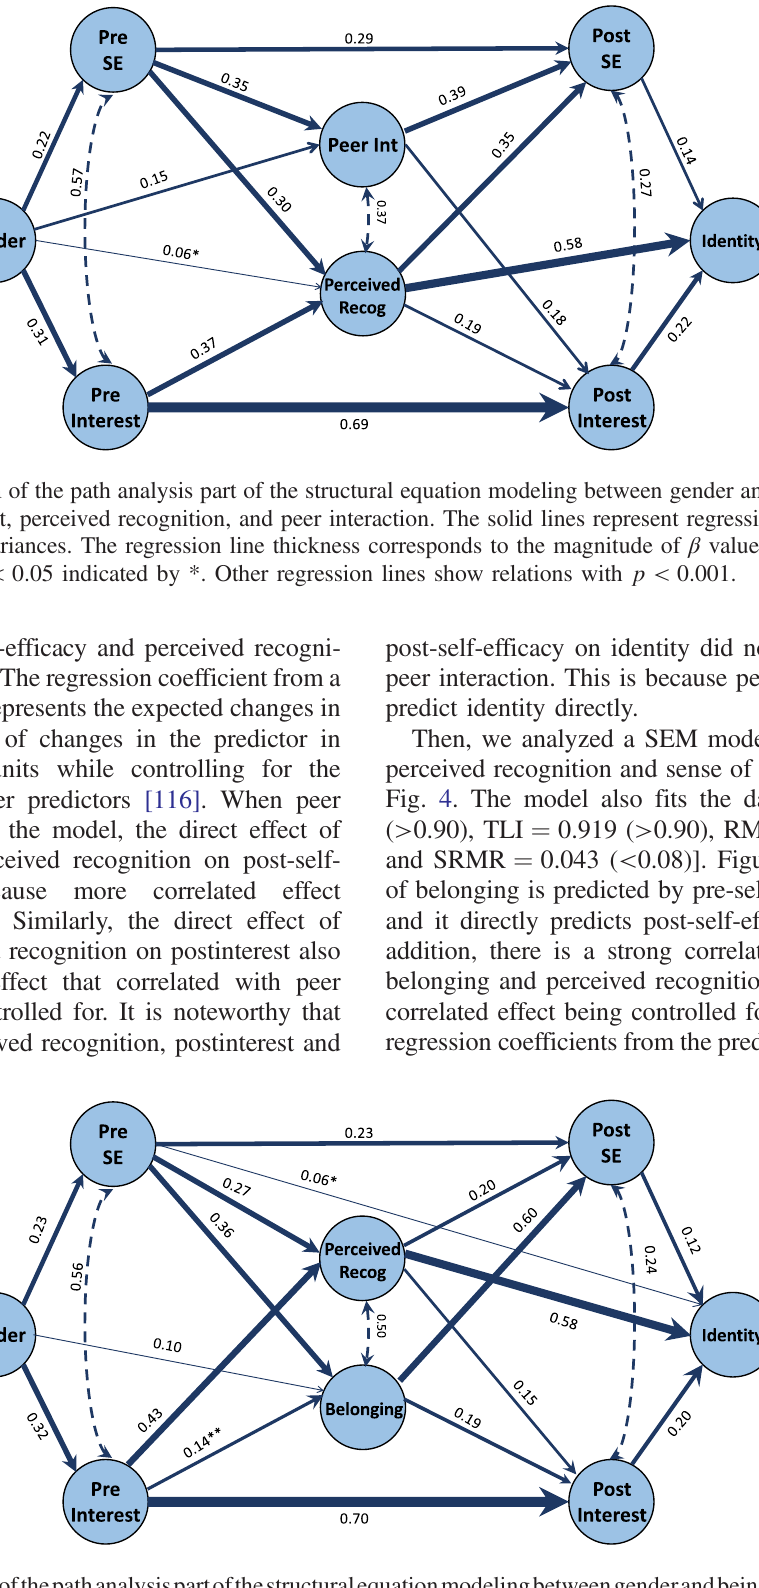
FIG. 4. Schematicdiagramofthepathanalysispartofthestructuralequationmodelingbetweengenderandbeingaphysicspersonthrough self-efficacy, interest, perceivedrecognition, and peer interaction. The solid lines represent regression paths, and the dashed lines represent residual covariances. The regression line thickness corresponds to the magnitude of the β value (standardized regression coefficient) with 0 . 01 < p < 0 . 05 indicated by * and 0 . 001 < p < 0 . 01 indicated by **. Other regression lines show relations with p < 0 . 001